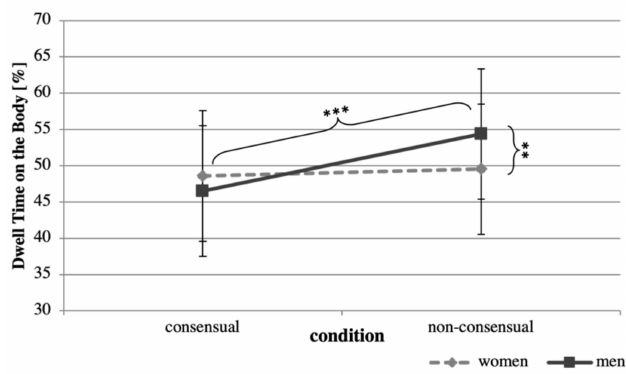
Figure 1. Estimates of the mean proportion (and standard error) of dwell time spent on the body by condition and gender. *** p < 0.001; ** p <